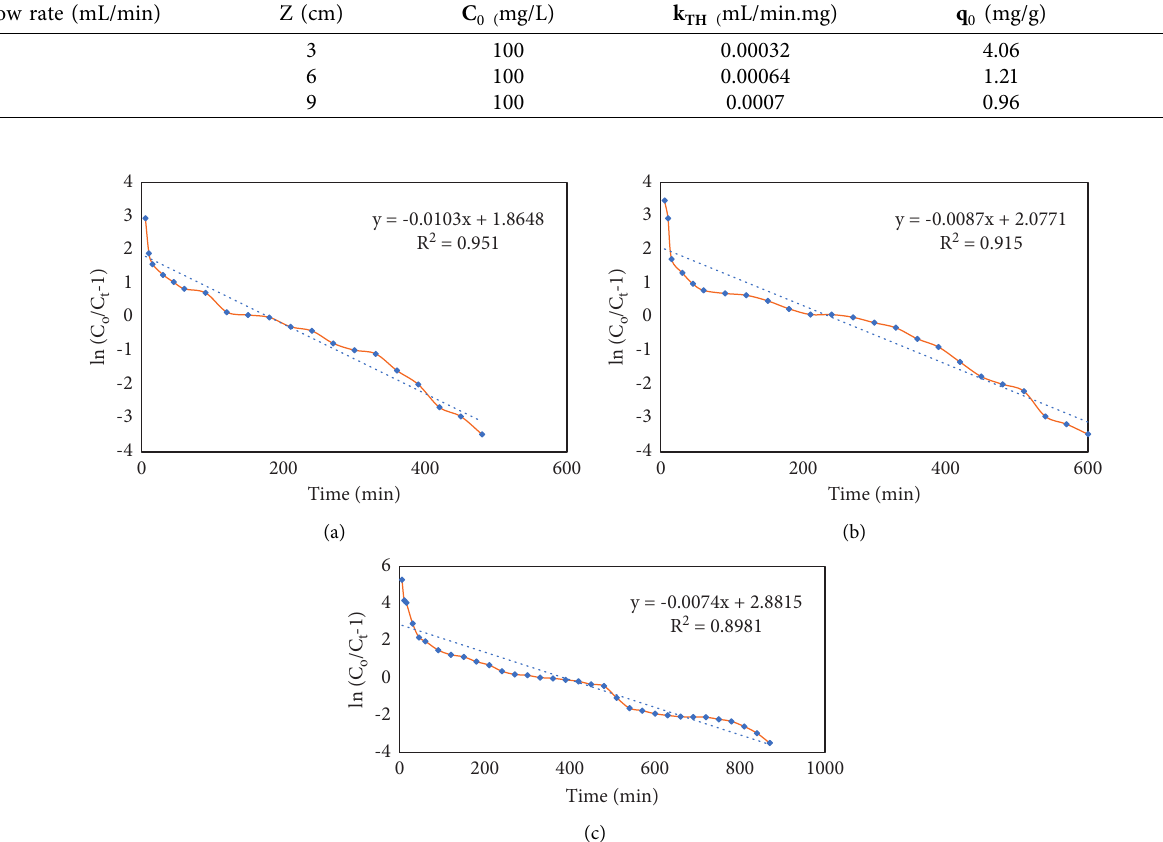
Figure 10: Thomas model plot for cadmium removal at different bed depths. (a) Bed depth of 3cm. (b) Bed depth of 6cm. (c) Bed depth of 9cm.